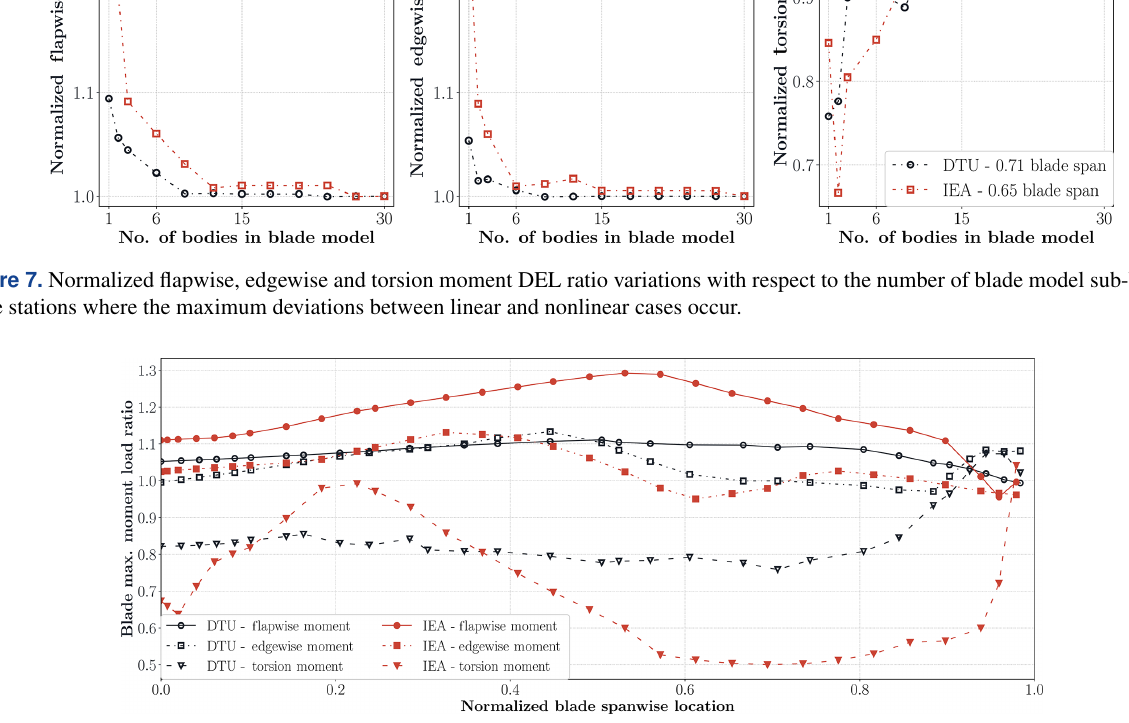
Figure 8. Linear and nonlinear blade absolute maximum moment load result ratio variation in DTU10MW and IEA10MW turbines with respect to blade span